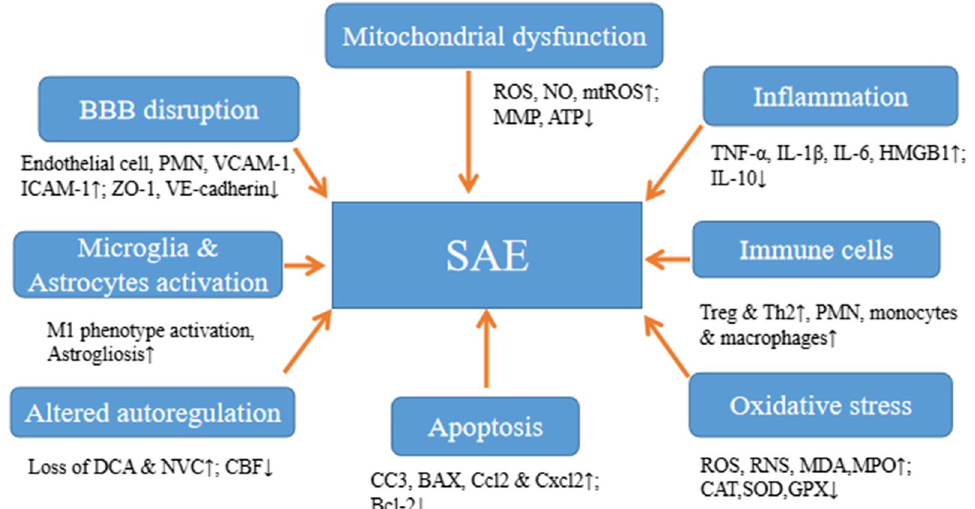
Fig. 1 Proposed pathophysiological mechanisms involved in SAE. SAE Sepsis-associated encephalopathy, TNF-α tumour necrosis factor alpha, IL-1β Interleukin 1beta, HMGB1 High-mobility group box 1, VCAM-1 Vascular cell adhesion molecule 1, ICAM-1 : Intercellular adhesion molecule 1, SOD Superoxide dismutase, CAT Catalase, NO Nitric oxide, ROS Reactive oxygen species, RNS Reactive nitrogen species, PMN Polymorphonuclear cells, mtROS mitochondrial reactive oxygen species, GPX Glutathione peroxidase, MDA Malondialdehyde, MPO Myeloperoxidase, MMP Mitochondrial membrane potential, DCA Dynamic cerebral autoregulation, NVC Neurovascular coupling, CBF Cerebral blood flow, ZO-1 Zonular occludens 1, CC3 Cleaved caspase 3, Tregs Regulatory T cells, Th2 helper T